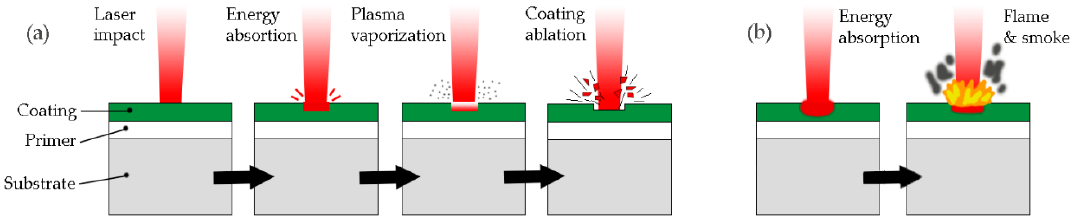
Figure 11. Graphic example of the stripping procedure with a laser source: ( a ) by photomechanical effect, ( b ) by photothermal effect.